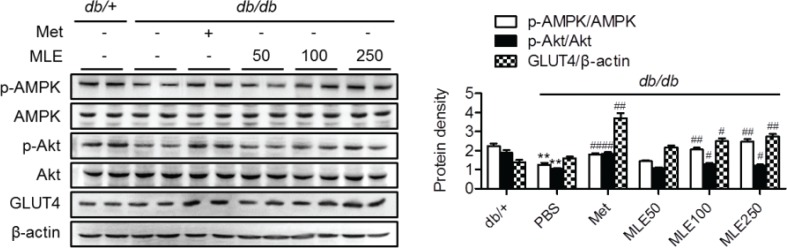
Activation of PI3K/Akt signaling pathways by MLE in muscle. At the end of the study, the total and phosphorylated forms of Akt and AMPK, and GLUT4 were measured in skeletal muscle tissues. The band intensities of each form were quantitated. Values are expressed as mean±SEM (n = 7/each group). **p < 0.01 versus db/+ and #p < 0.05, ##p < 0.01 versus db/db+PBS.